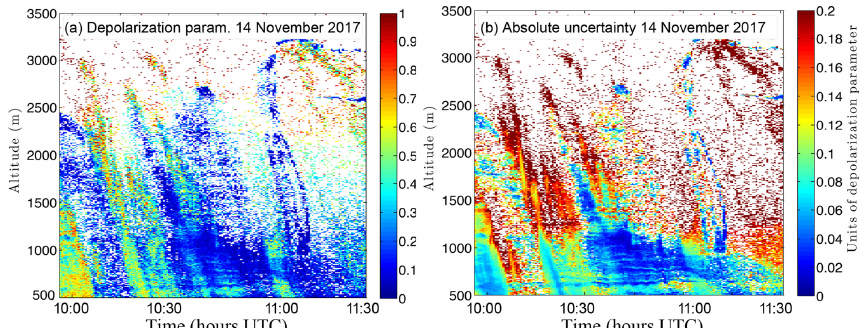
Figure A2. 14 November 2017. Panels (a, b) same format as A1 (a, b)